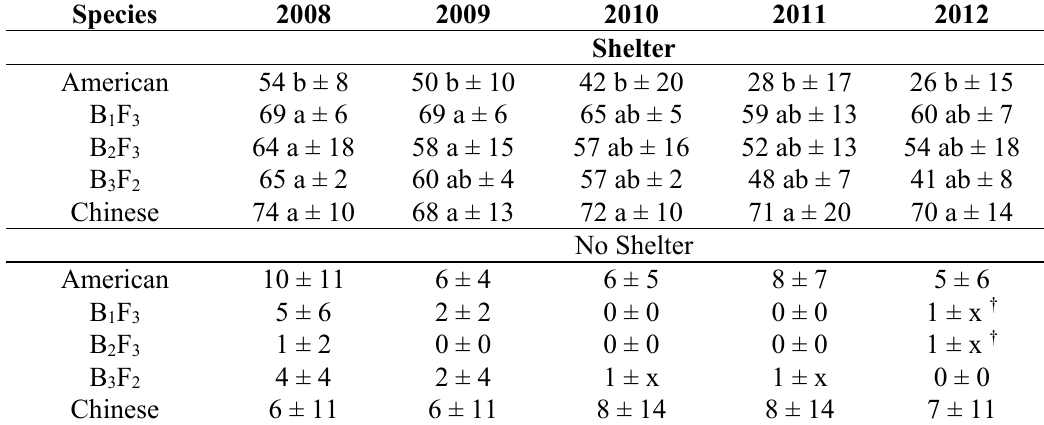
Table 2. Mean percent survival (and standard deviation) of chestnuts planted into mine soil in Eastern Kentucky, compared within chestnut types and between sheltering treatments. Different letters indicate a significant shelter effect ( p < 0.05) within species. (SD of “x” indicates sample size is too low).